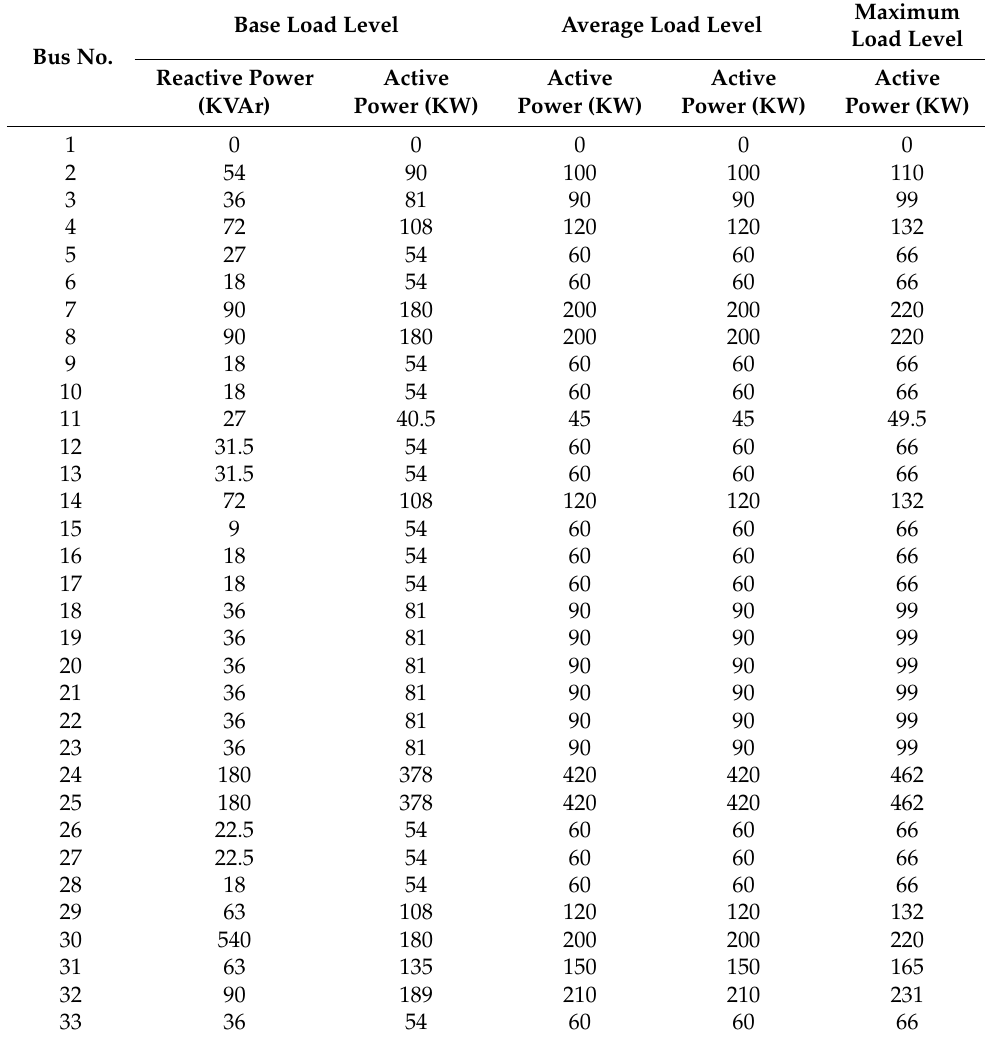
Table 1. Different network load